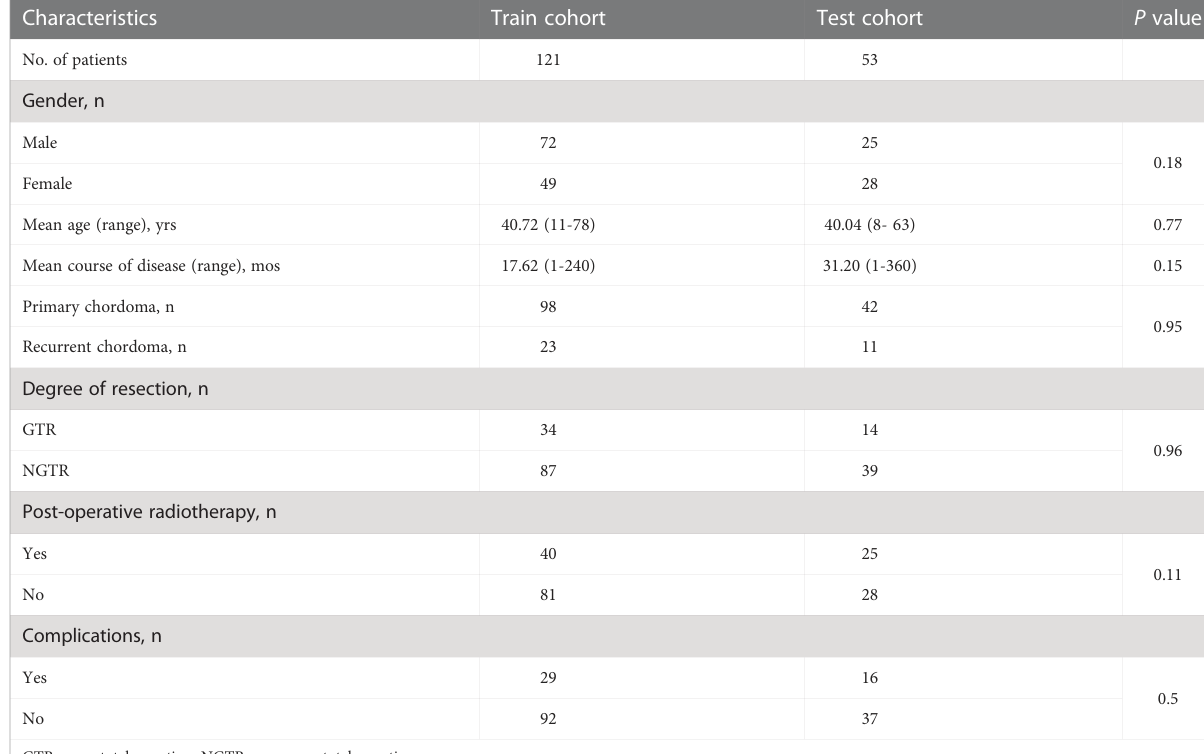
TABLE 1 Patient